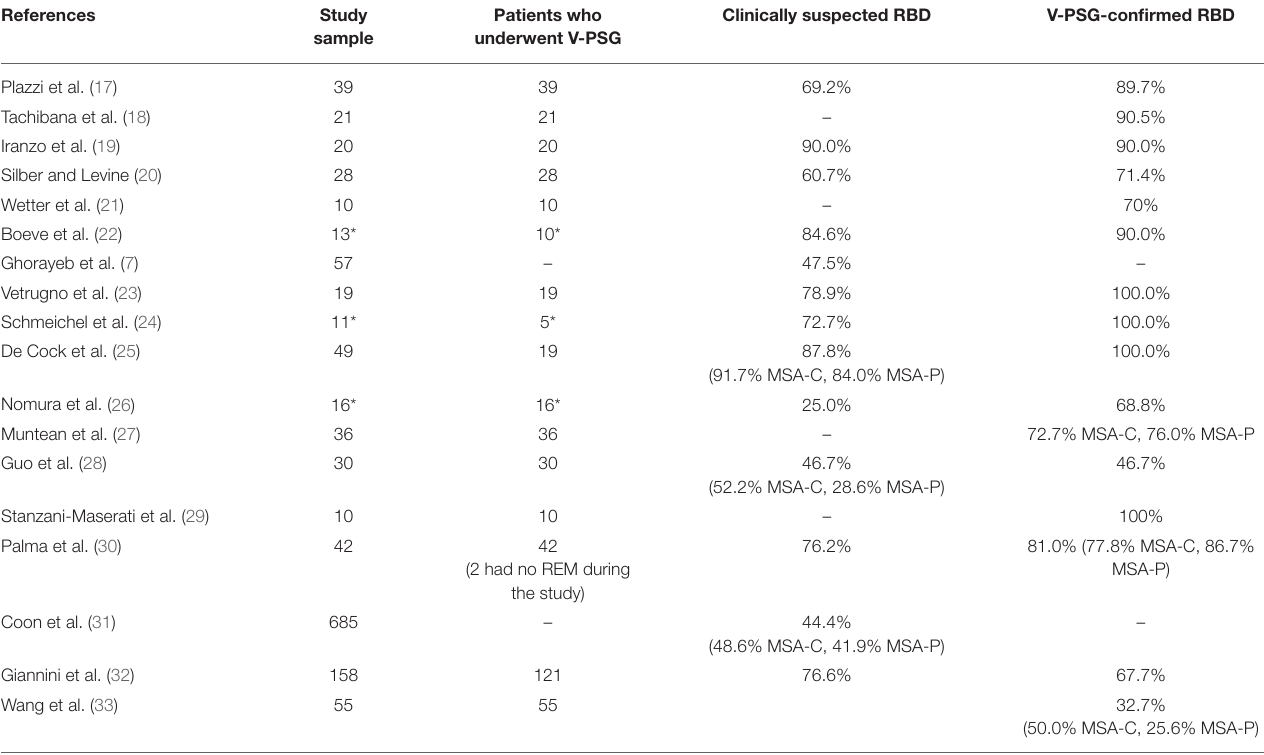
TABLE 1 | Studies focused on the prevalence of clinically suspected or V-PSG-confirmed RBD in MSA